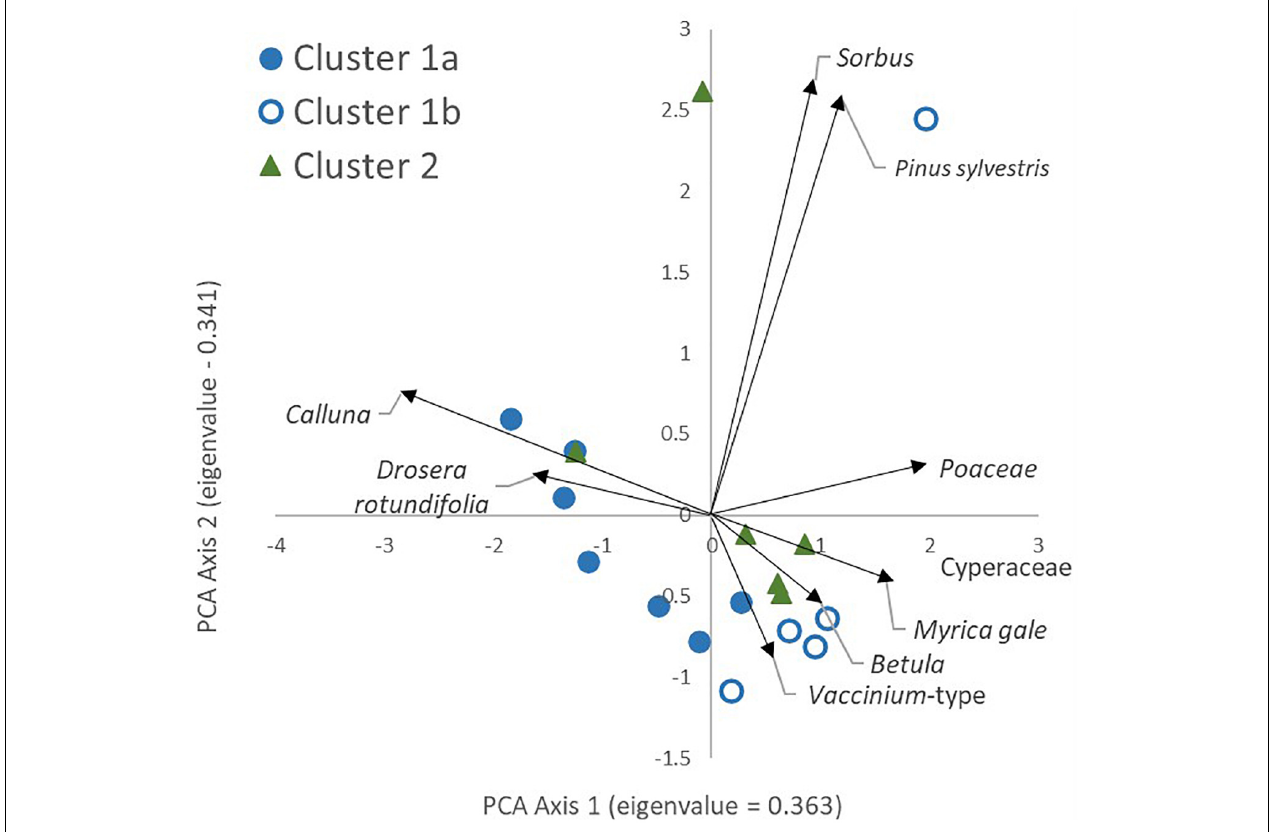
FIGURE 4 | Principal Components Analysis of pollen assemblages (percentage data, square root transformation). Colour/fill of sample locations denotes the WinTWINS vegetation cluster each belongs to. Only the nine most abundant pollen types are shown on the figure for